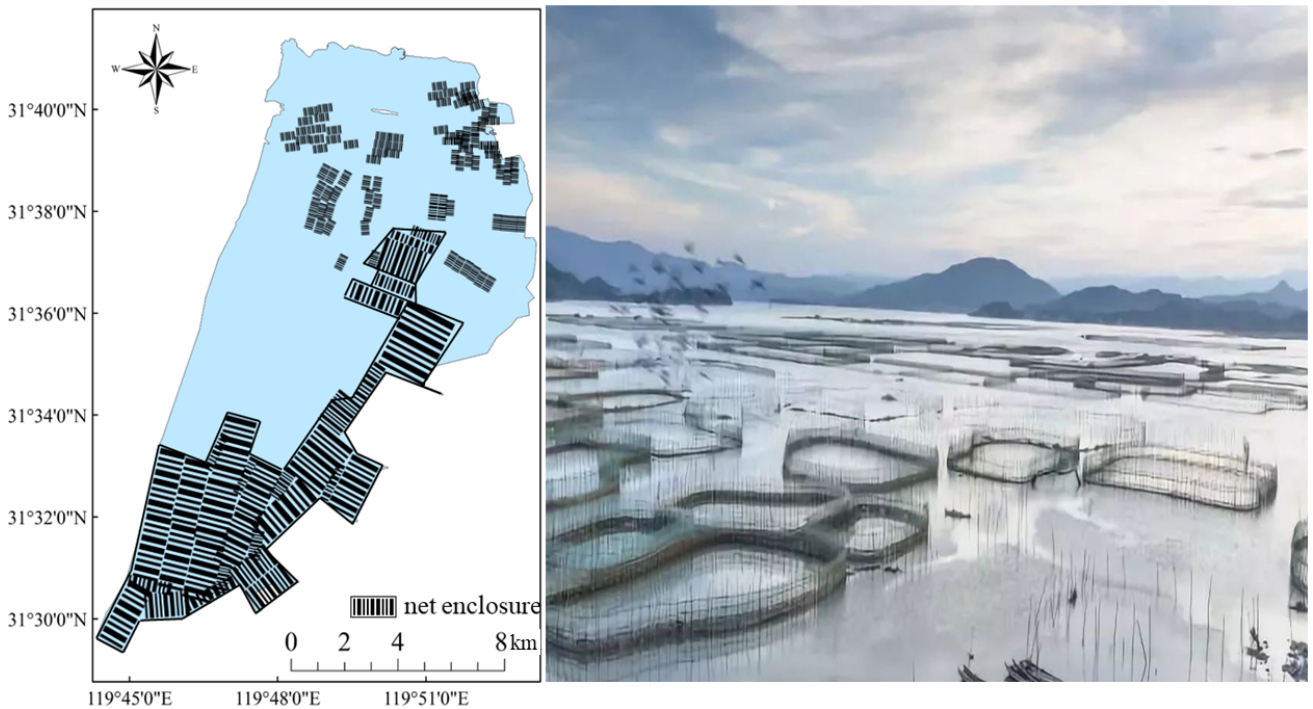
Figure 1. Schematic diagram of the pen culture region in Gehu Lake in 2017–2018. The photo of the pen culture facilities is from https://m.sohu.com/a/271925579_649720?_trans_=010004_pcwzy (accessed on 29 October 2018).